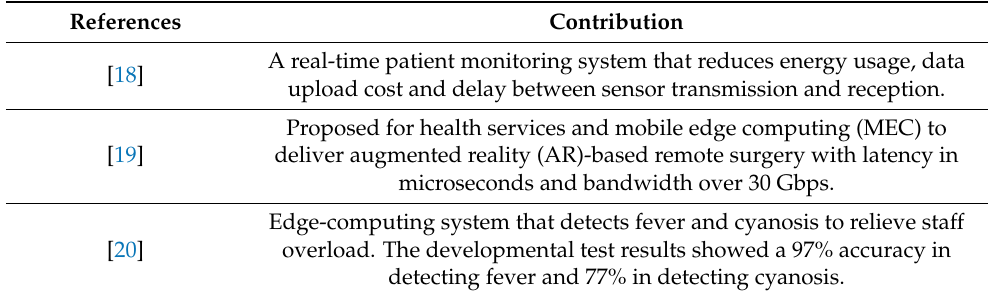
Table 1. Studies on edge computing in the area of healthcare.